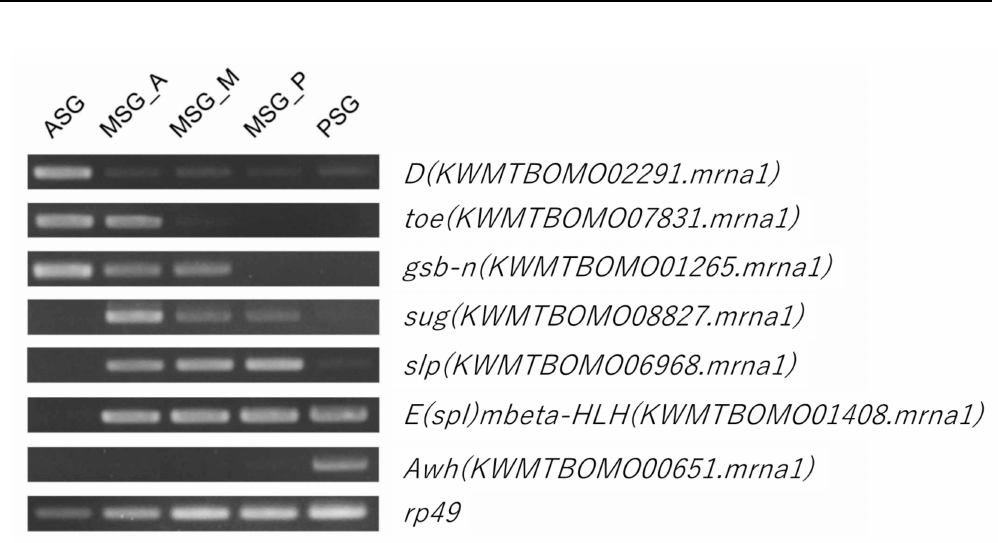
Figure 11. RT-PCR of TF transcripts showing territory-specific expression in the